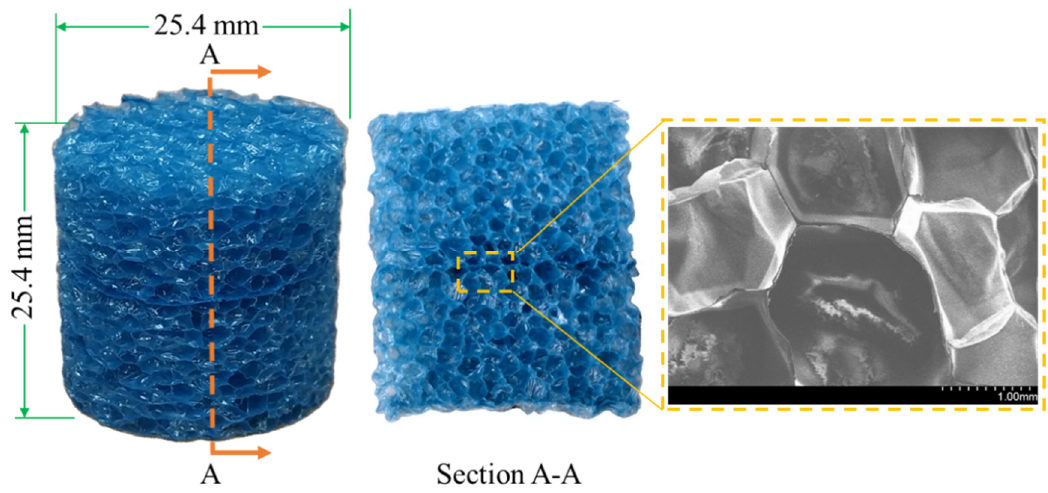
Figure 3. The structure of the PE foam specimen. The density is 27.2 kg/m 3 , the average diameter and the wall thickness of the cell are 1.49 mm and about 0.017 mm, respectively. Both the diameter and height of the specimens are 25.4 mm.